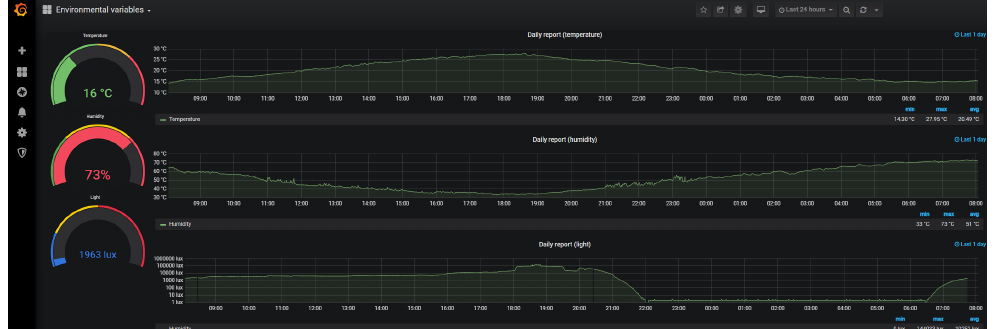
Figure 11. Example of visualization of environmental variables.